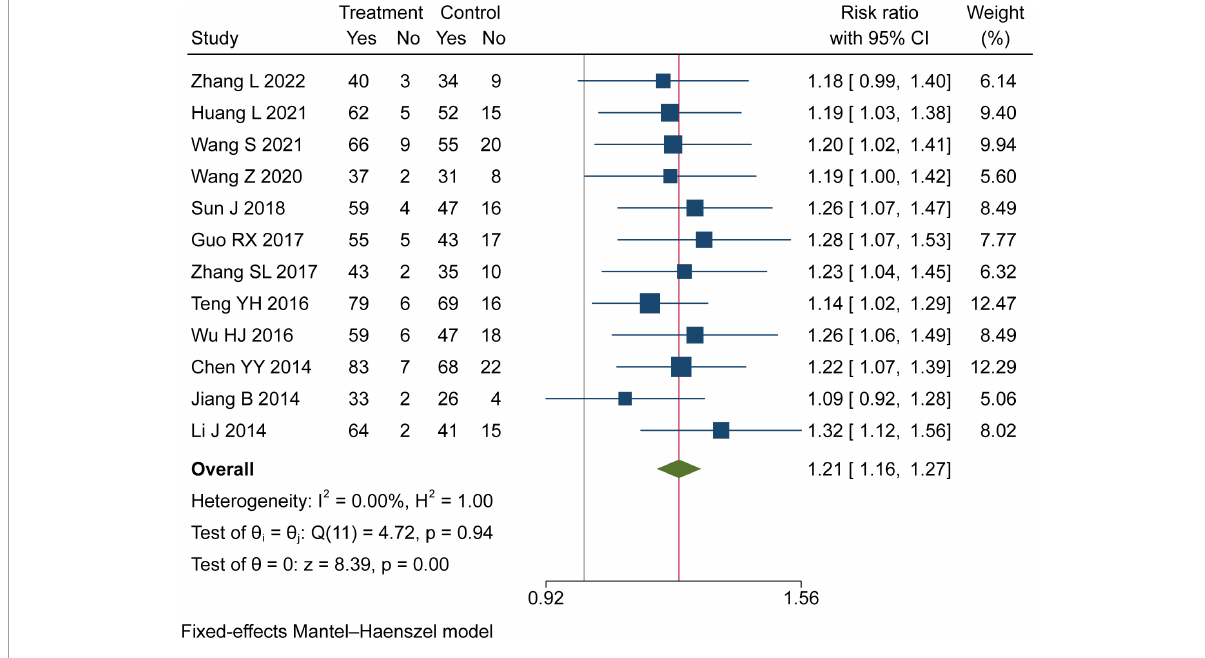
FIGURE3 Forest plot of clinical efficacy rate.